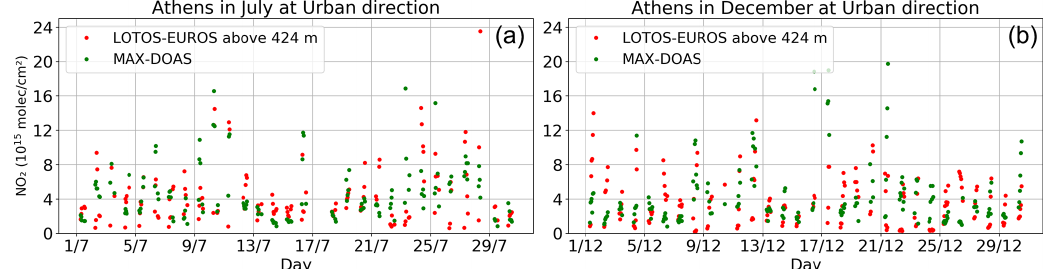
Figure 8. Time series of LOTOS-EUROS (red) and MAX-DOAS (green) NO 2 columns over Athens for July (a) and December (b) 2018 in the urban